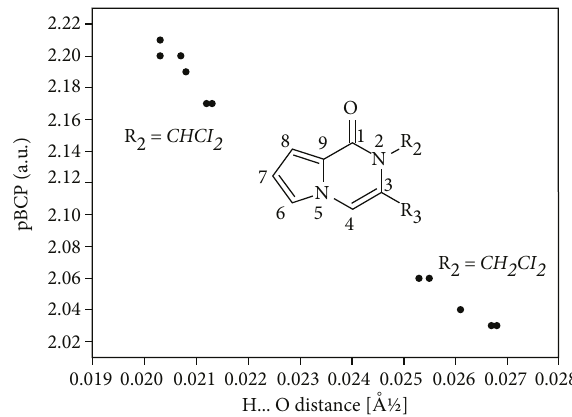
Figure 2: Correlation between electron density at the H-bond critical points ρ (in a.u.) and the H … O distance (in Å) was BCP calculated at the B3LYP/aug-cc-pVDZ level. (4, 7, 10, 13, 16, 19, and 22; R =CHCl ) (5, 8, 11, 14, 17, and 20; R 2 2